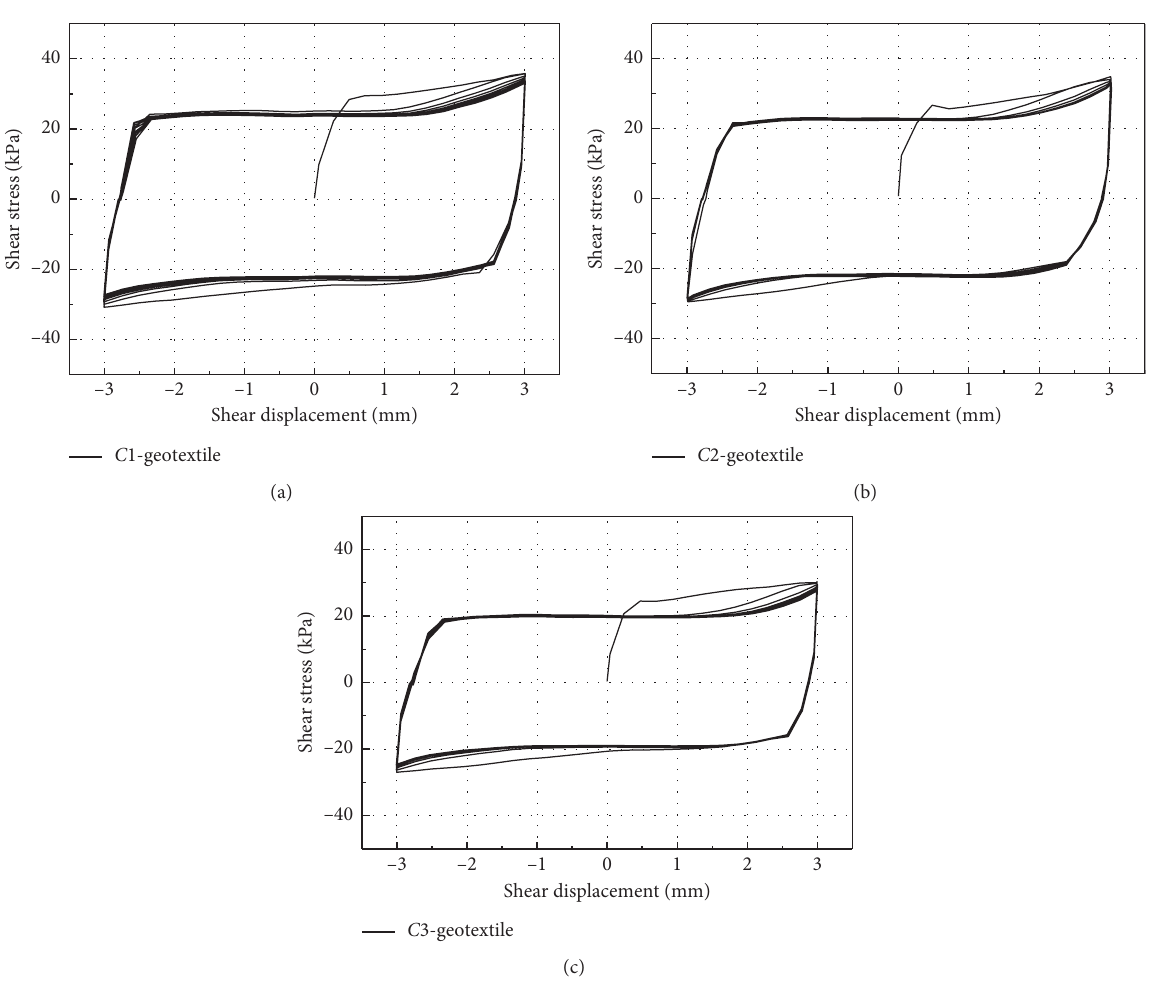
Figure 3: Effect of sand particle-size gradation on the interface shear stress-shear displacement curves in the CDS